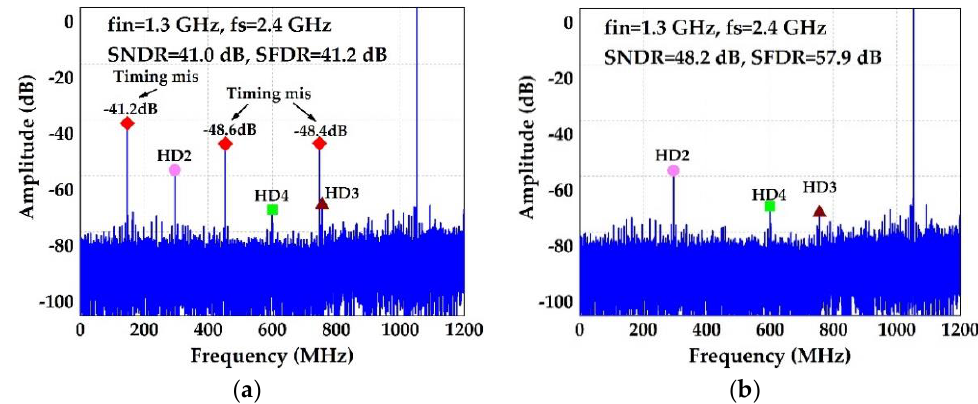
Figure 15. Measured output spectrum when fin = 1.3 GHz ( a ) before timing mismatch calibration and ( b ) after timing mismatch calibration.